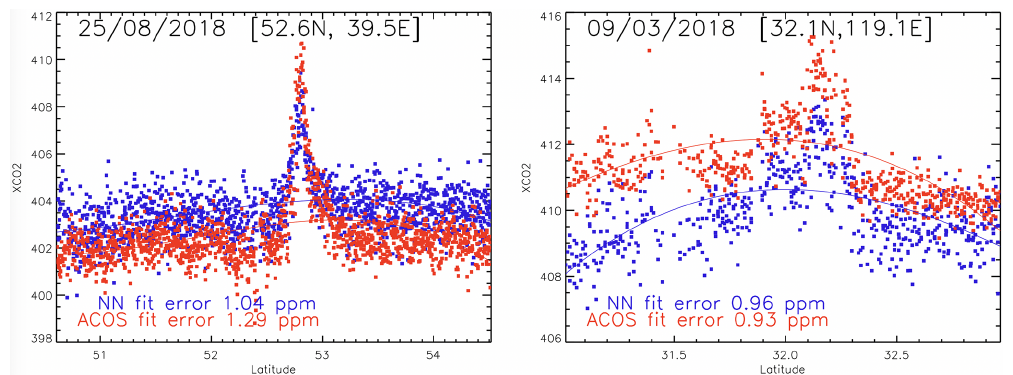
Figure 4. Two examples of XCO 2 plumes that are captured by the ACOS bias-corrected XCO 2 estimates. These were not shown by the first version of the NN algorithm (an example shown in Fig. A1) but are well captured by the second version that does not use the wCO2 band (shown here). The NN estimates are in blue whereas the ACOS estimates are in red. The lines are simple polynomial fits on the XCO 2 estimates and do not aim at capturing the plume signature. These cases were identified and discussed in Reuter et al.